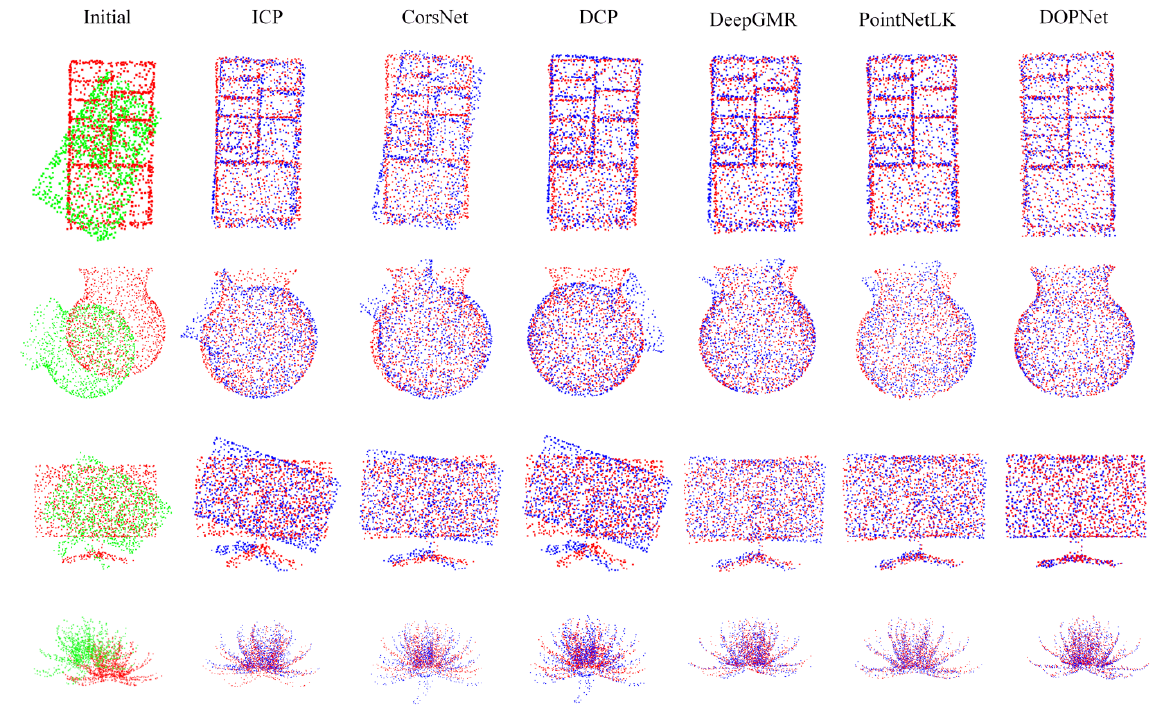
Figure 3. Registration results (red: target point cloud; green: source point cloud; blue: predicted point cloud). The first column shows the initial position of the point clouds, while other columns show the registration results.